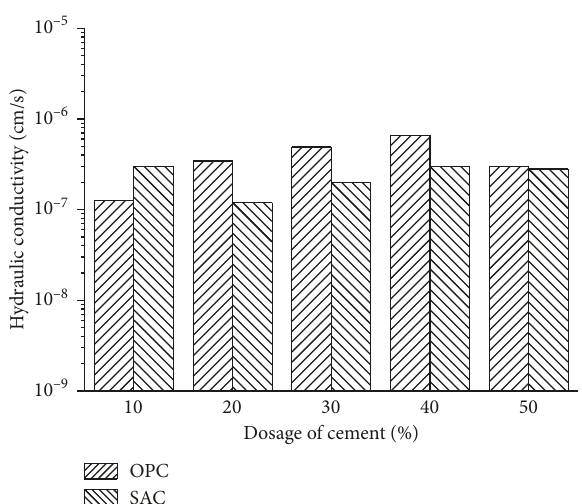
Figure 1: Hydraulic conductivity of solidified sludge with different cement